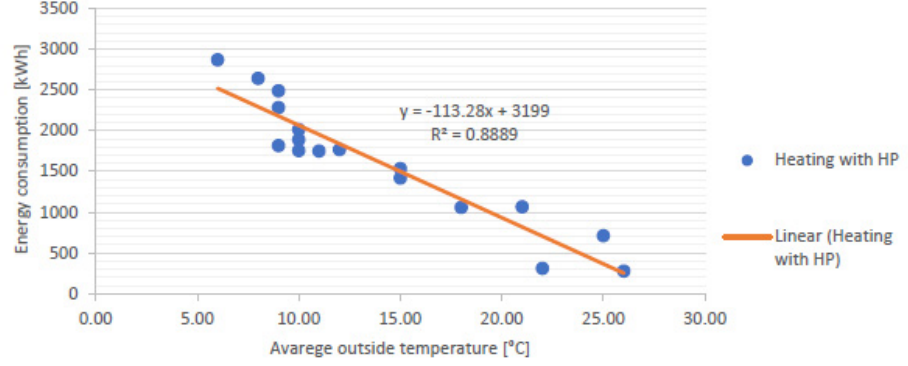
Figure 2. Linear regression analysis between monthly energy consumption and outdoor average.